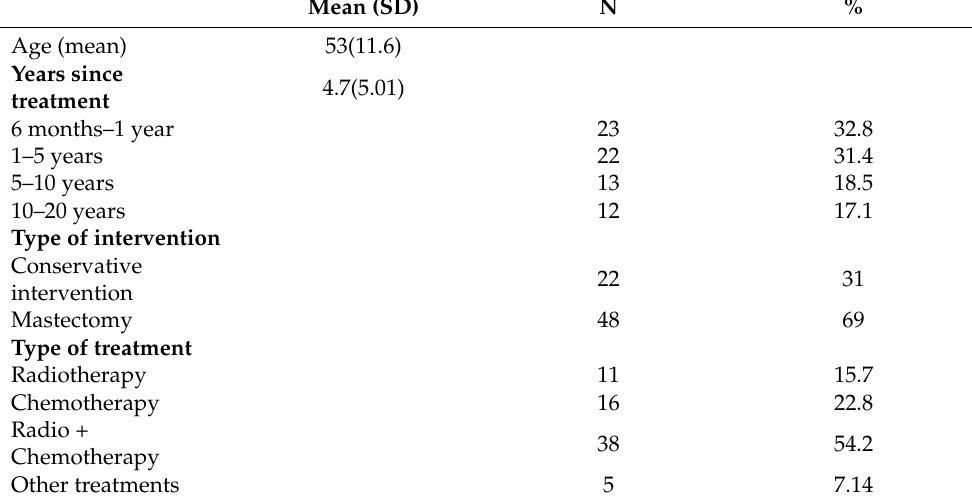
Table 1. Demographic